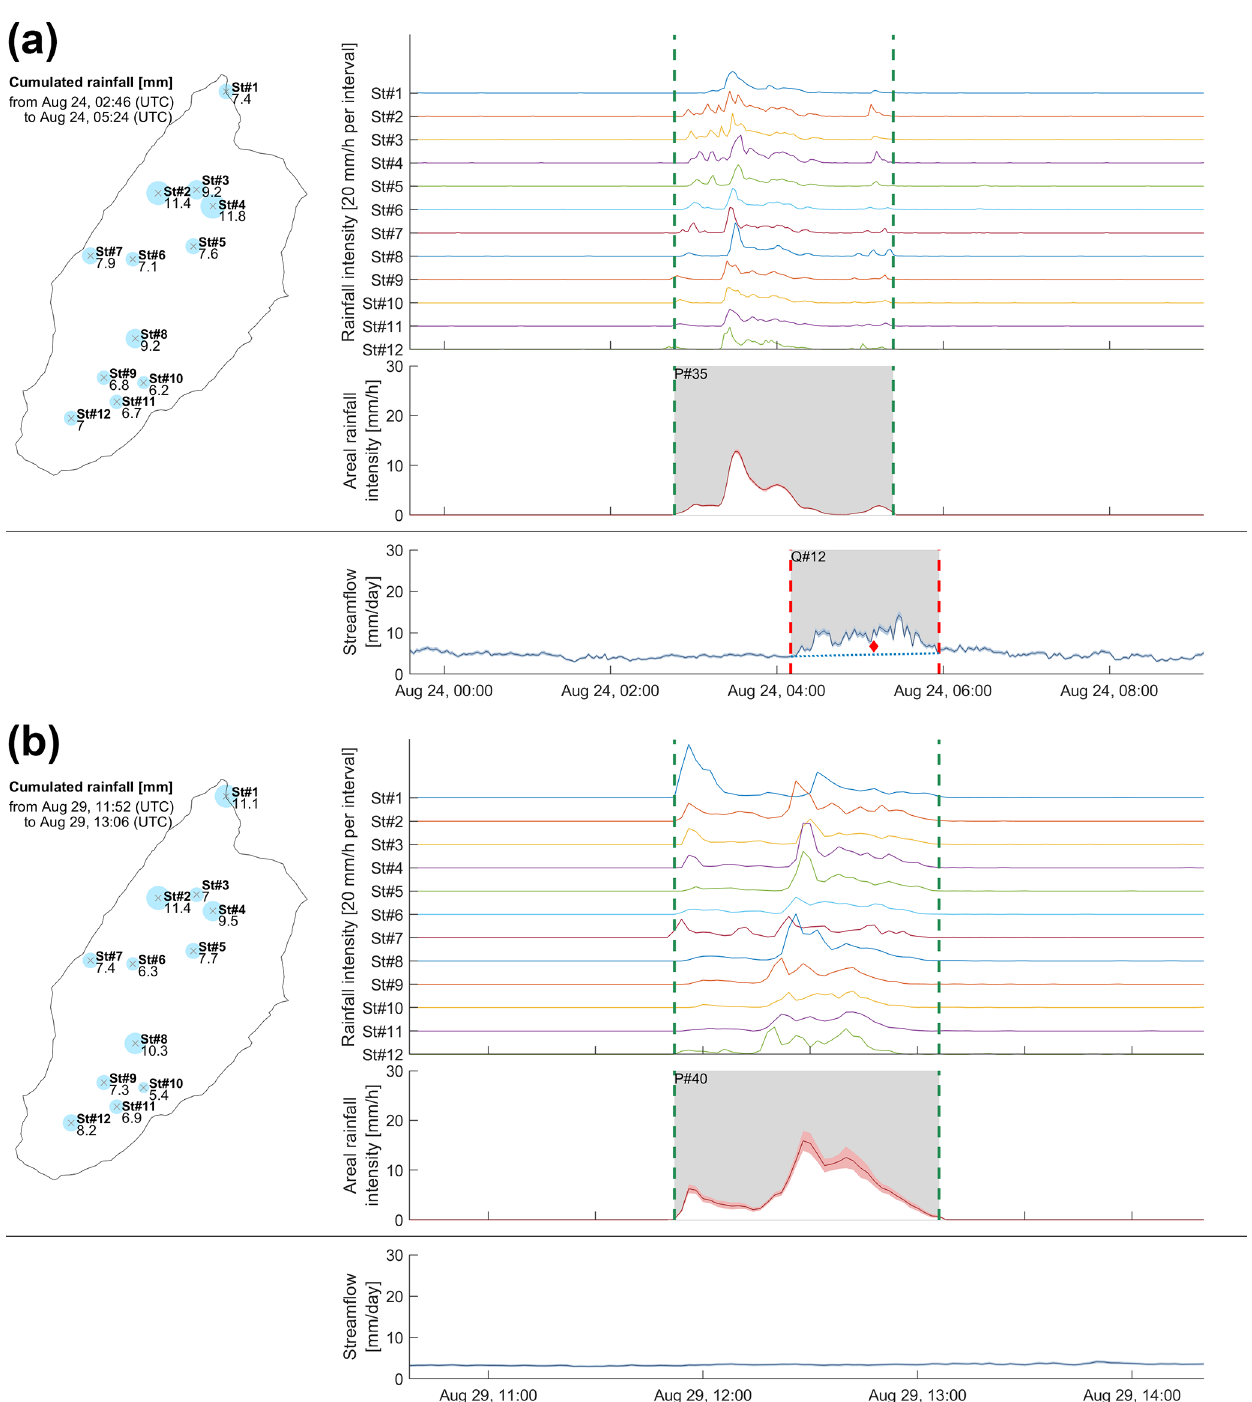
Figure 4. Summary of the recorded rainfall and streamflow for the rainfall events of 24 August 2018 at 02:46 (a) and 29 August 2018 at 11:52 (b)